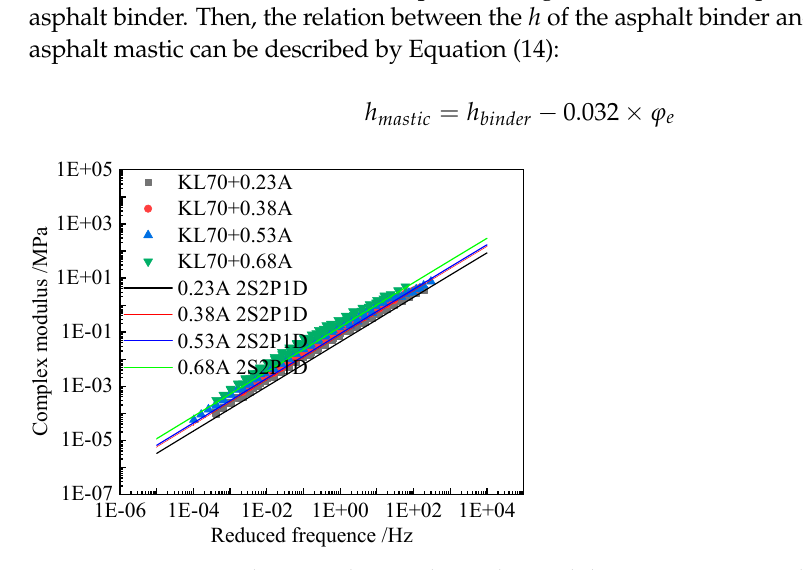
Figure 9. Comparison between the tested complex modulus master curves and 2S2P1D model fitted results of KL70 (B) asphalt mastics.